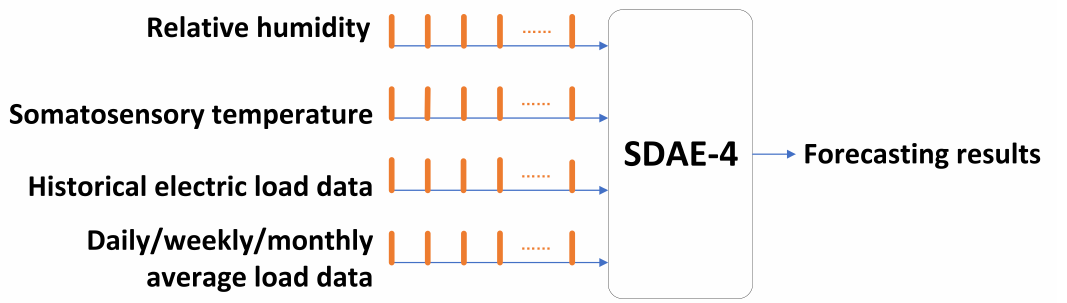
Figure 7. The framework of